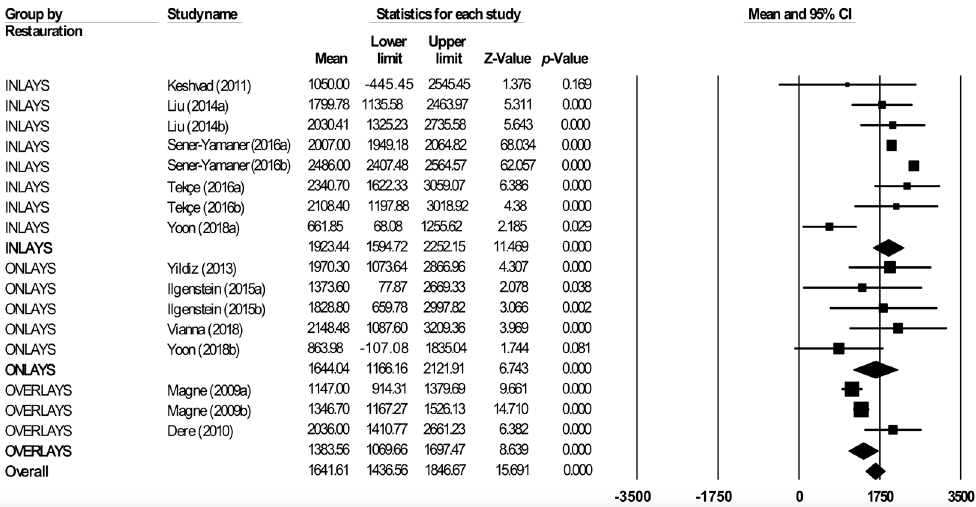
Figure 5. Forest plot of meta-analysis of subgroups according to restoration type (inlays, onlays, and overlays). The size of the square represents the weight of each study and the diamond represents the combined results of the meta-analysis. CI is the 95% confidence interval of the mean between a lower and an upper limit.